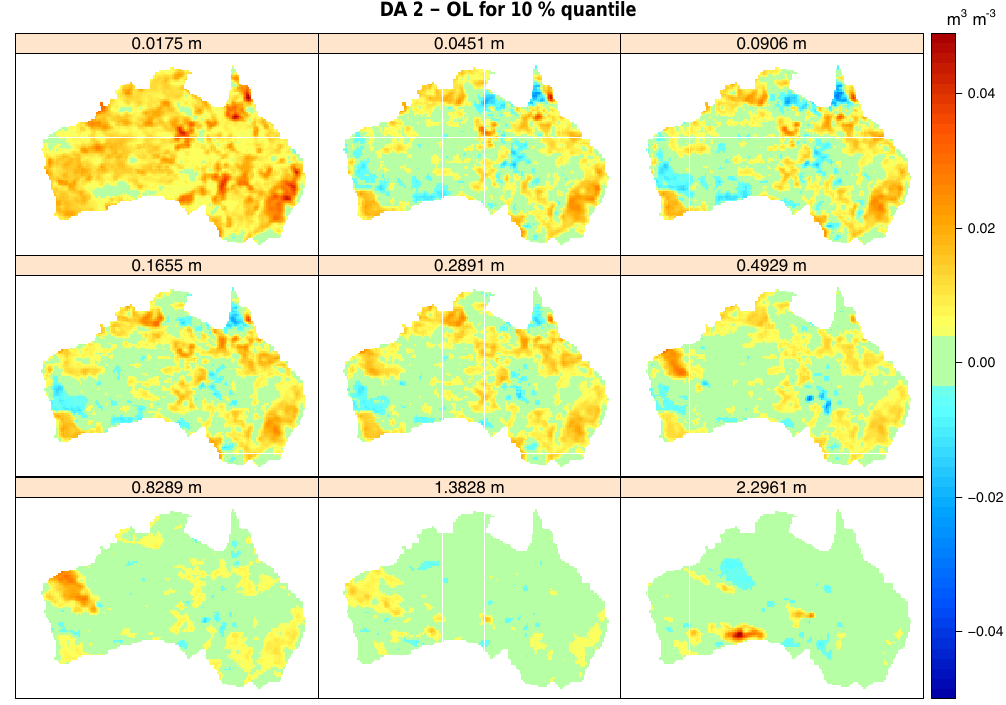
Figure 11. Differences in relative soil moisture between open-loop and DA 2 experiments (DA 2 – OL) for the 10% quantile. The individual panels correspond to the top nine CLM soil